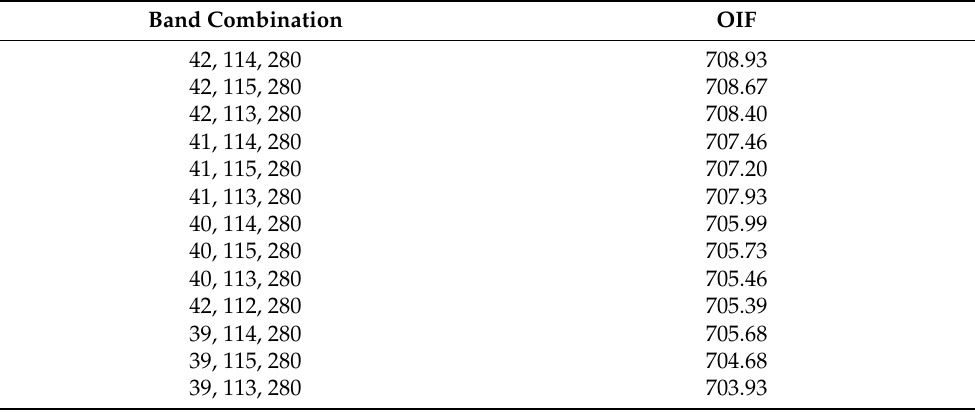
Table 2. Results of OIF for different band combinations of GF-5 images. Band